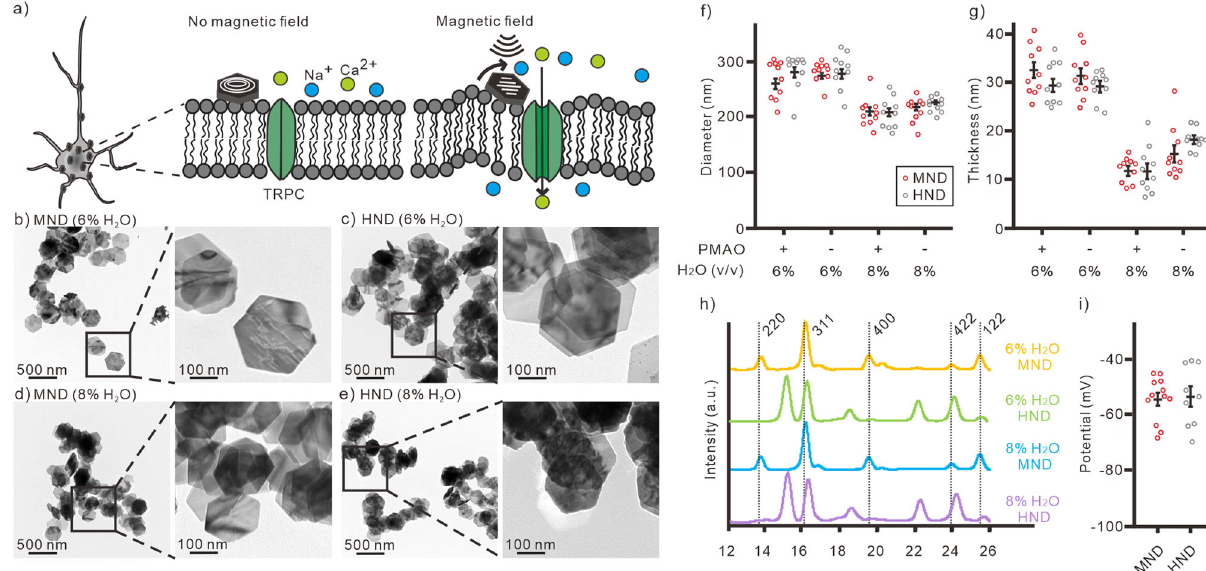
Fig. 1 Synthesis of MNDs for magnetomechanical stimulation. a Schematic of magnetomechanical stimulation by using MNDs. TEM images of PMAO- coated MNDs ( b ) and HNDs ( c ) with 6% H 2 O in the reaction solution at the fi rst step of reaction. TEM images of PMAO-coated MNDs ( d ) and HNDs ( e ) with 8% H 2 O in the reaction solution at the fi rst step of reaction. f Diameter of nanodiscs measured from TEM images (All groups, n = 10). g Thickness of nanodiscs measured from TEM images (All groups, n = 10). Statistical analysis of diameter and thickness are shown in Table S1-3. h XRD spectra of MNDs and HNDs from different conditions. i The zeta-potential of PMAO-coated MNDs ( n = 12) and HNDs ( n = 9). p = 0.917, Mann-Whitney test. Error bars represent mean ± Standard mean of error